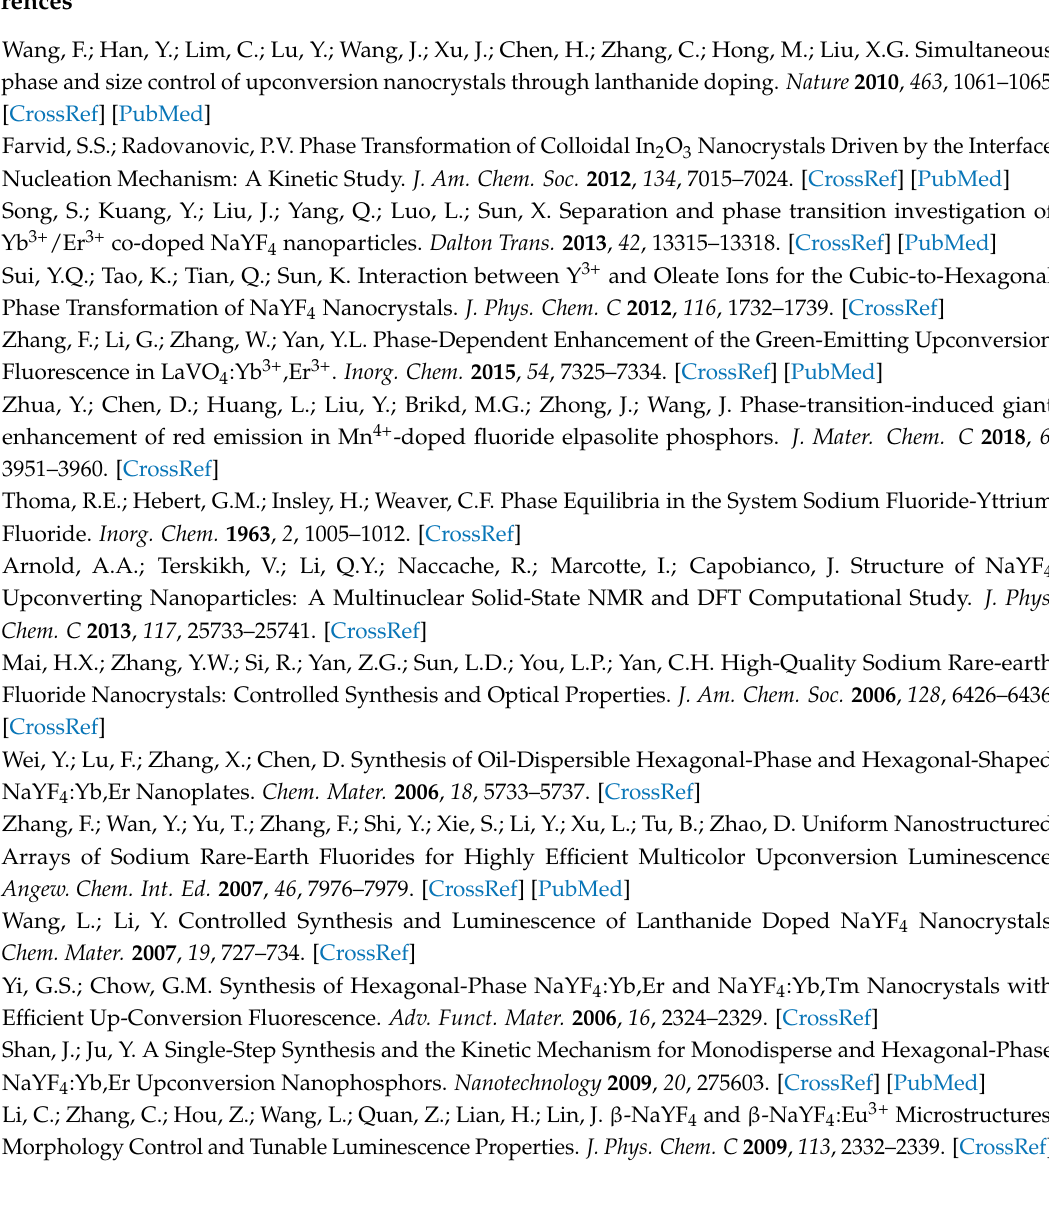
Figure S1: XRD pattern of the sample using BmimBF 4 as fluorine source (The bar represents the standard cards PDF#70-1935 for YF 3 ), Figure S2: XRD patterns of NYF:Yb 3+ ,Er 3+ (20/2 mol%) NCs via LSS method at (a) 120 ◦ C and (b) 220 ◦ C (The bars in (a) and (b) represent the standard cards PDF#77-2042 and #PDF16-0334,